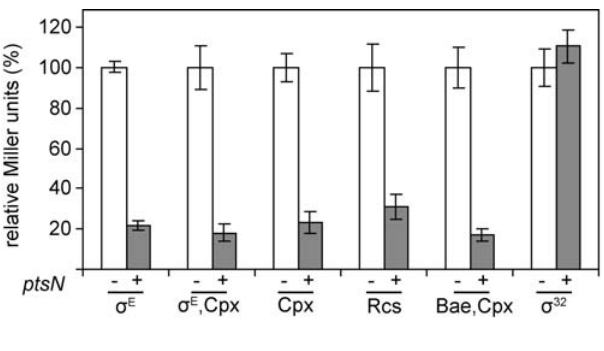
Figure 7. Overexpression of ptsN reduces cell envelope stress. b -galactosidase activity from the rpoH P3- lacZ ( s E , SEA4254), degP - lacZ ( s E and Cpx, SEA4181), cpxP - lacZ (Cpx, SEA4179), rprA - lacZ (Rcs, SEA4199), spy - lacZ (Cpx and Bae, SEA4189), and htpG - lacZ ( s 32 , SEA4185) fusions was measured in overnight cultures, with and without overexpression of ptsN . Activity of each lacZ fusion was normalized to that of cultures with no ptsN overexpression and set to 100%. Average values and standard deviations from a minimum of 3 experiments are shown.